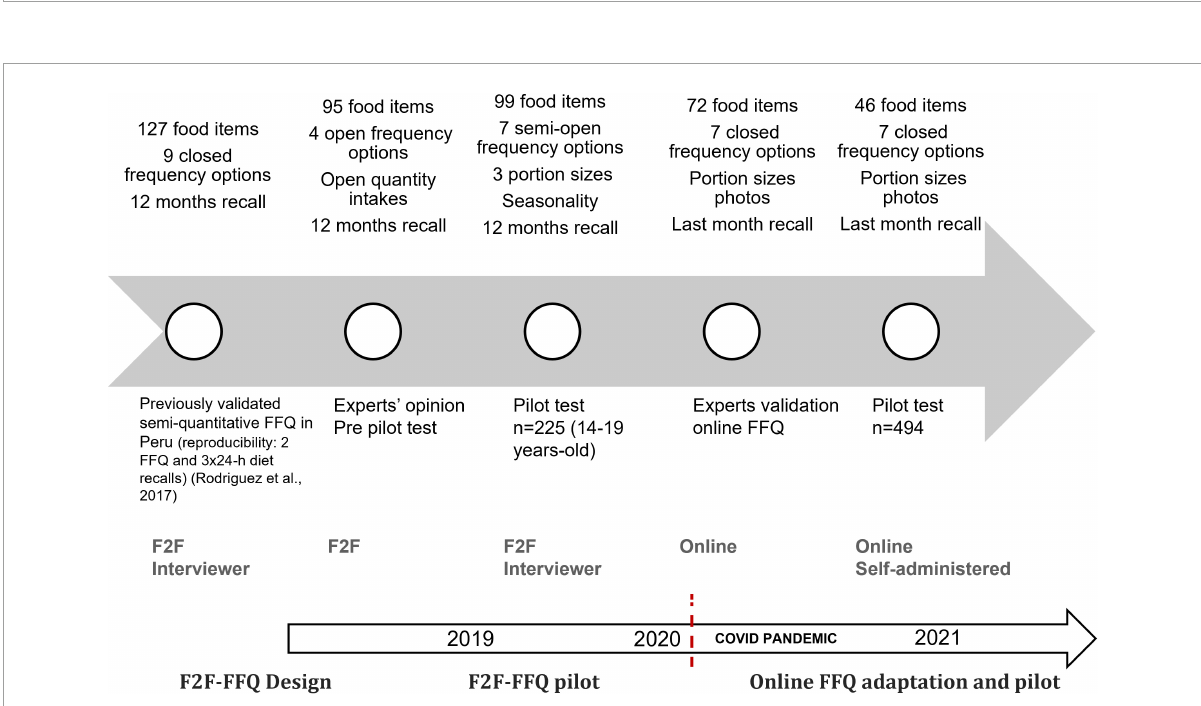
FIGURE2 FFQ development processes. F2F, face-to-face; FFQ, food frequency